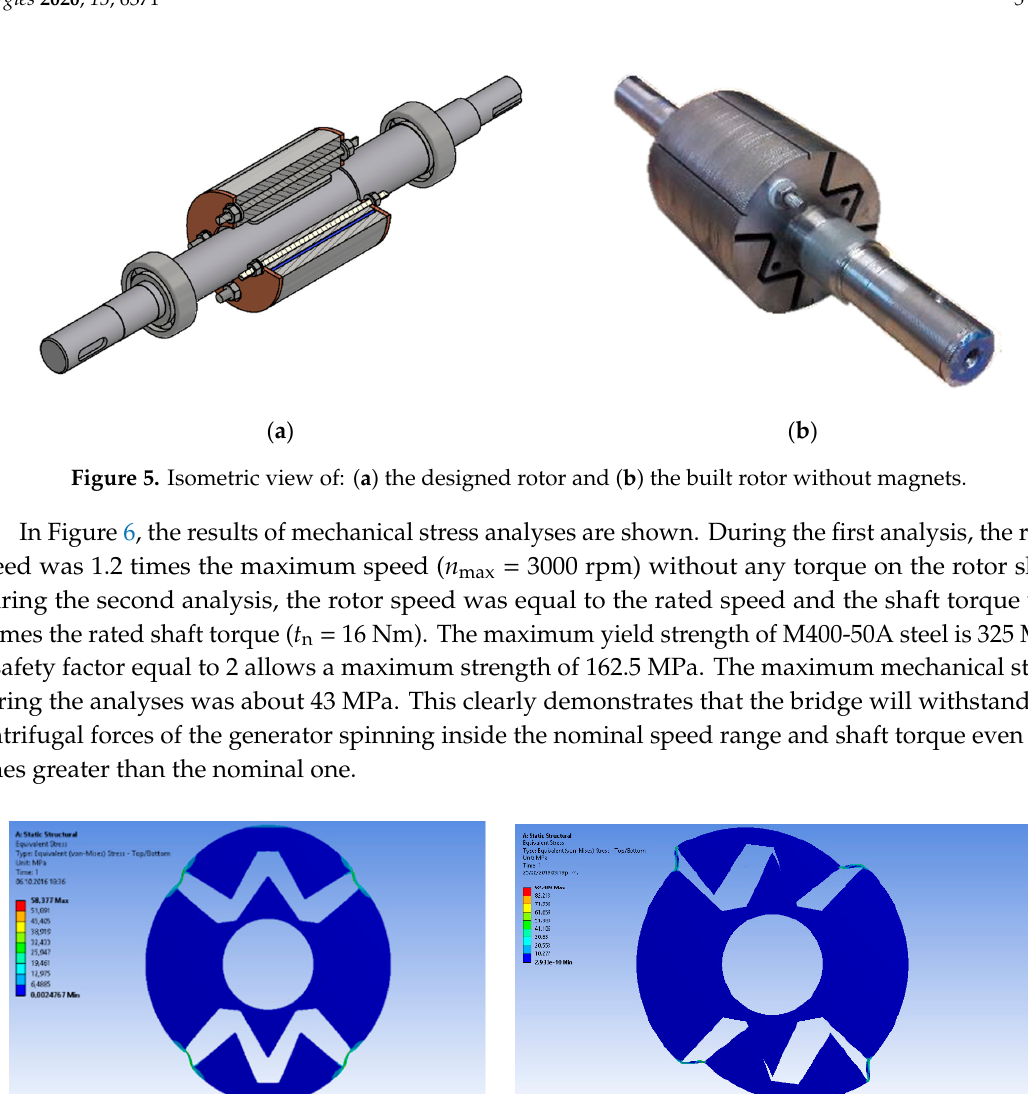
Figure 8. Back EMF of the healthy PMSG; dotted lines are FEA results. FEA results predicted 90% efficiency when operating at 1500 rpm and a nominal input torque of 16 Nm. This can be confirmed by the measurements shown in Figure 9. In Figure 10, the calculated efficiency map of the generator is shown. Notice that the calculated maximum efficiency is about 90%. This was corroborated by laboratory measurements also shown in Table 2. These measurements were conducted only with a three-phase resistor (56 ohm). The FEA results appear to be in good agreement with the measurements conducted in the laboratory. Once again, the similarities between the measurements and FEA transient results are evident.